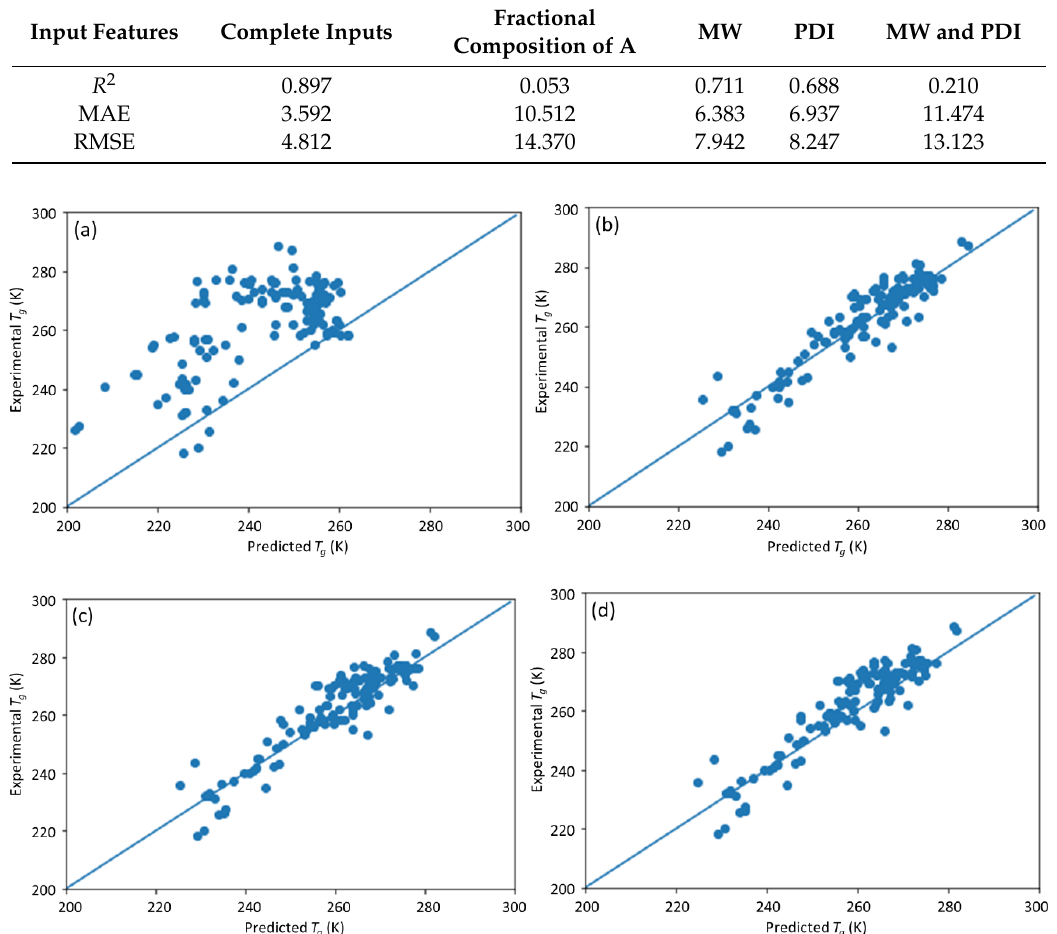
Figure 11. Scatter plots of predicted vs. experimental T g with di ff erent input factors estimated via their minimal values. ( a ) Fractional composition of A; ( b ) molecular weight; ( c ) PDI; ( d ) molecular weight and